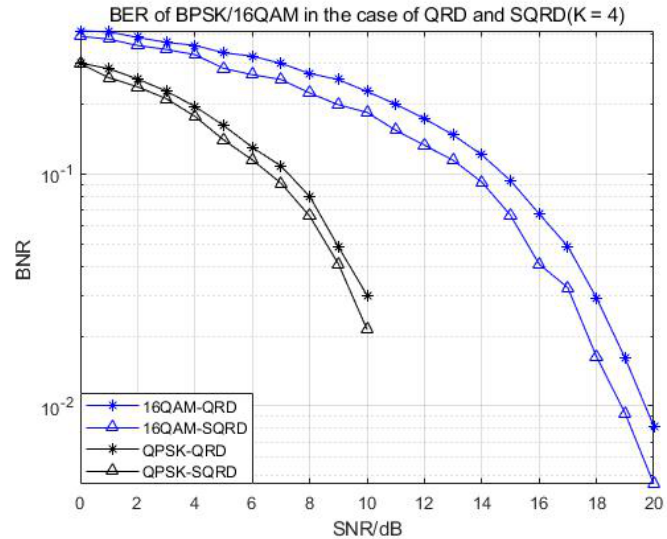
Figure 5. BER of BPSK/16-QAM in the case of QRD and SQRD (K = 4).